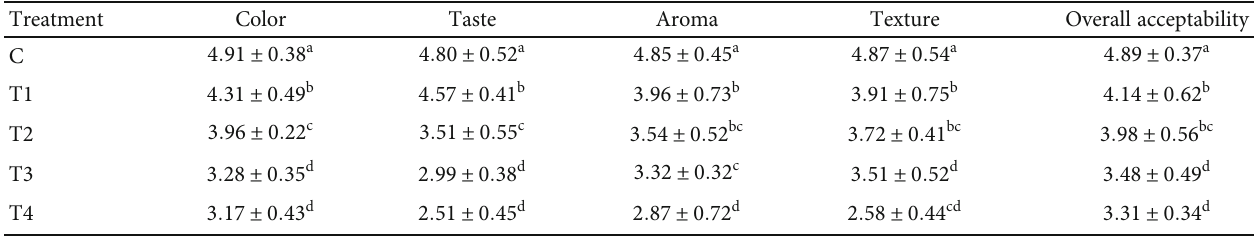
Table 3: E ff ect of blending ratio on sensory acceptability of wheat-moringa noodles. Treatment Color Taste Aroma Texture Overall